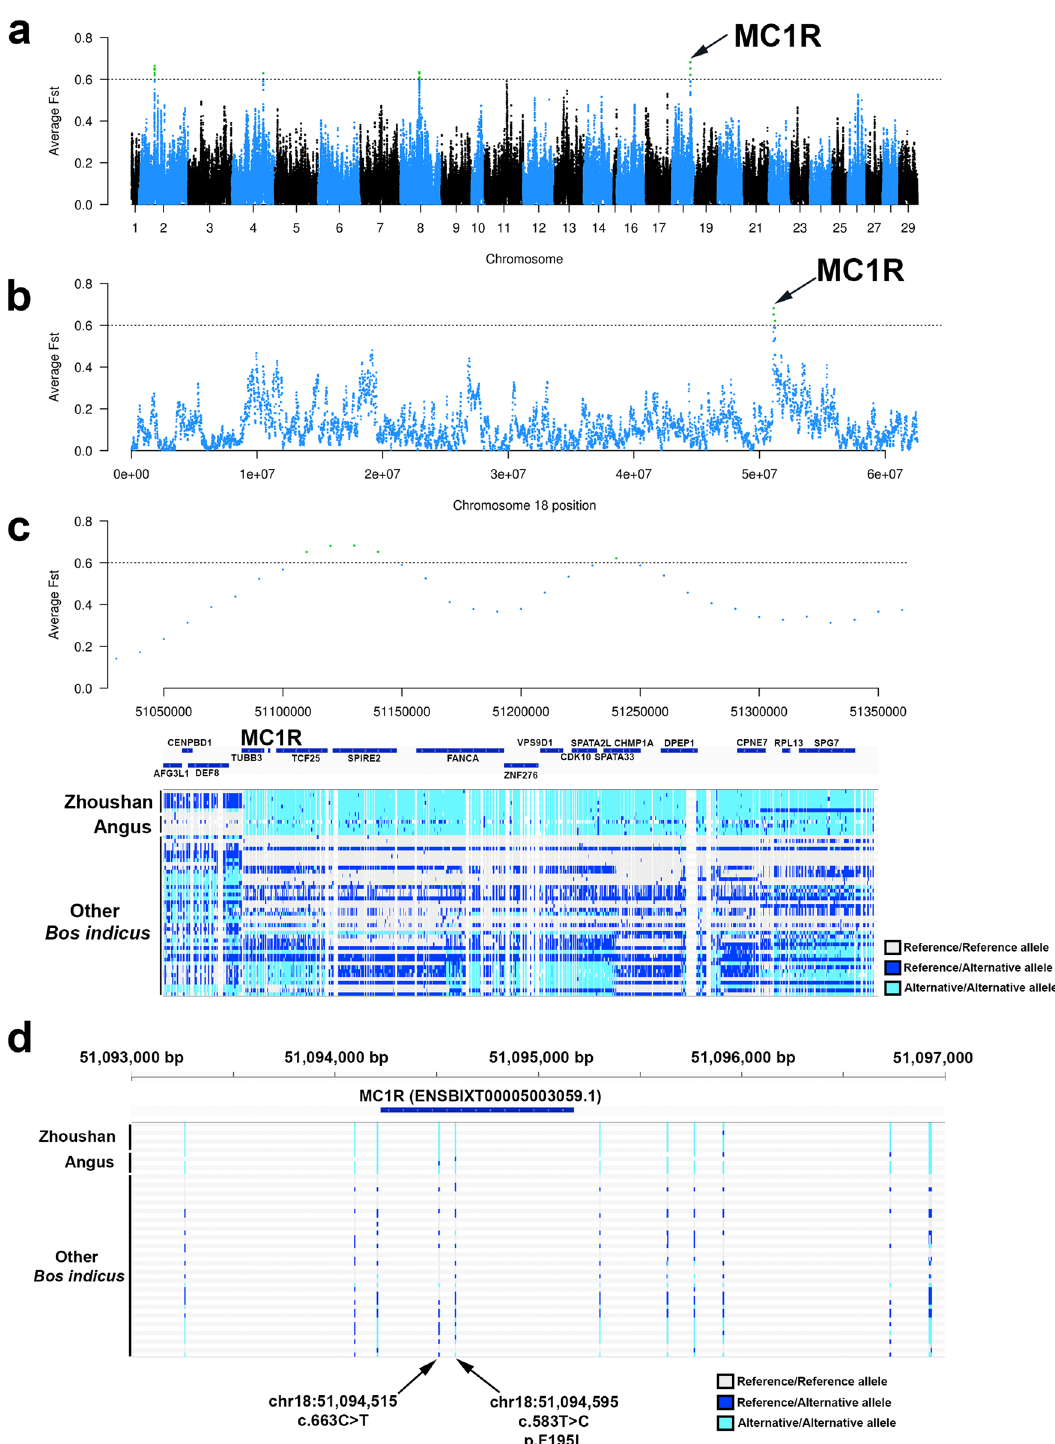
Figure 3. Genomic regions associated with dark black coat colour of Zhoushan cattle. ( a ) Manhattan plot for average Fst values in 40 kb windows with 10 kb steps between Zhoushan cattle plus Angus and other B. indicus . A region with an average Fst of more than 0.6 is coloured in green. The arrow indicates the highest peak. The x-axis represents chromosomal positions, and the y-axis represents the average Fst values. ( b ) Manhattan plot on chromosome 18 for average Fst values in 40 kb windows with 10 kb steps between Zhoushan cattle, Angus, and other B. indicus . ( c ) Regional plot around the MC1R gene. The genotype of each individual at each variant site is shown. The genotype homozygous for the reference allele is coloured grey. Heterozygous variants are coloured blue. The homozygous genotype for alternative alleles is coloured light blue. Note that homozygous genotypes for alternative alleles are enriched in Zhoushan and Angus cattle in this region. ( d ) Regional plot showing the mutations around MC1R